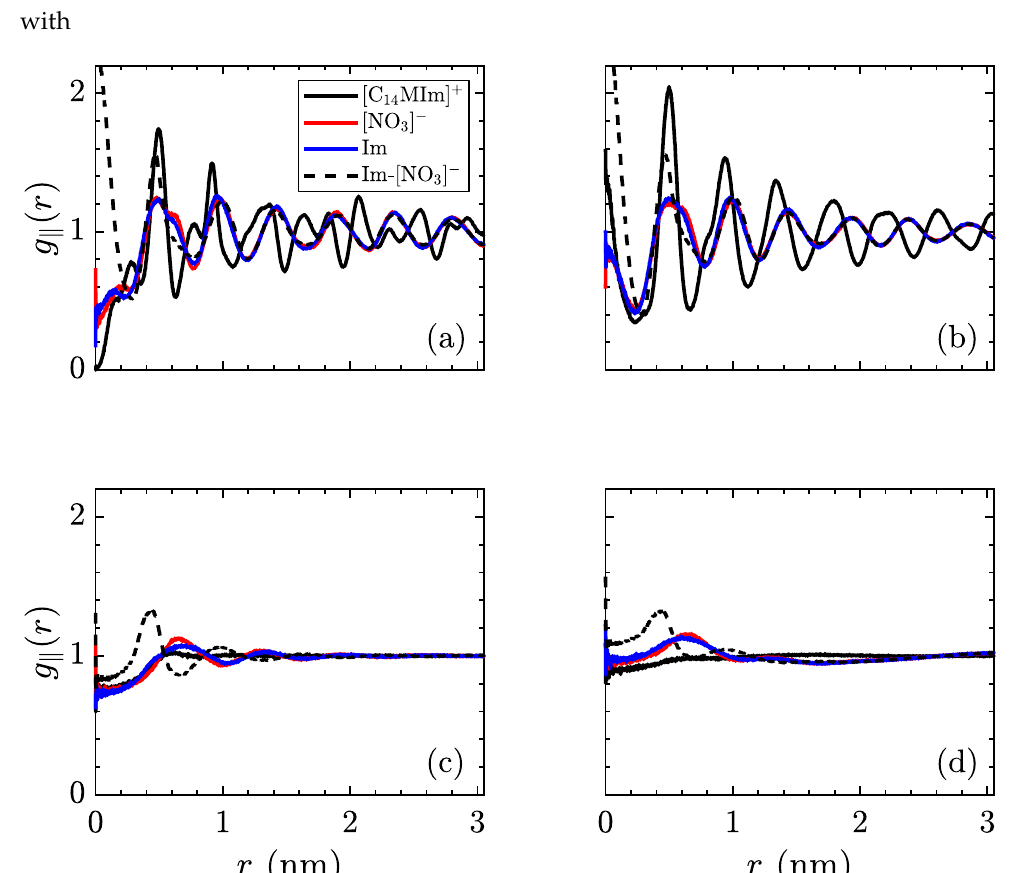
Figure 8. In-plane radial distribution function, g (cid:107) ( r ) of the species in [C 14 MIm][NO 3 ], trajectory- averaged over the last 200ns, at temperatures of ( a ) 400K in the crystalline state, ( b ) 450K just before the transition to the smectic-A state, ( c ) 500K in the smectic-A phase, and ( d ) 600K isotropic liquid. The solid lines signify the distribution of a species relative to its own type (black: [C 14 MIm] + , red: [NO 3 ] – , blue: imidazolyl ring) while the dotted line denotes placement of [NO 3 ] – ions in relation to imidazolyl rings. From ( a ) to ( b ), a significant decrease in order of tail groups is observed, with the loss of secondary peaks, while the correlations also decay slightly more quickly as a function of distance. The first phase transition is characterized by the alkyl tails losing almost all order within the xy -plane. The phase transition to the isotropic liquid loses almost all structure, except for pairing of the opposite